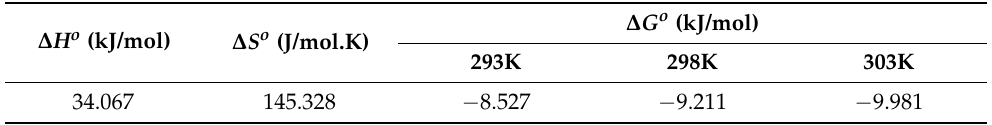
Table 3. Thermodynamic parameters for the adsorption of DBT on